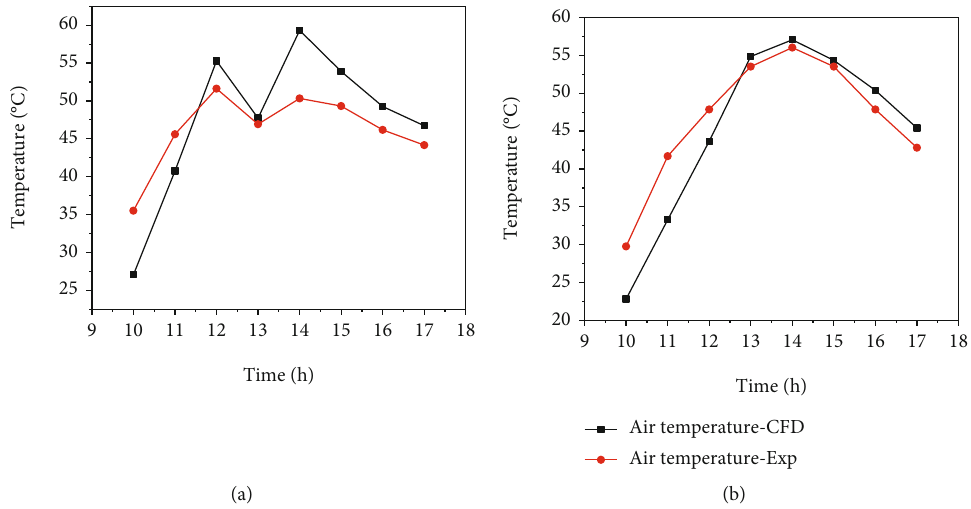
Figure 9: Comparison between the experimental and the simulation results of (a) day-1 and (b) day-2.